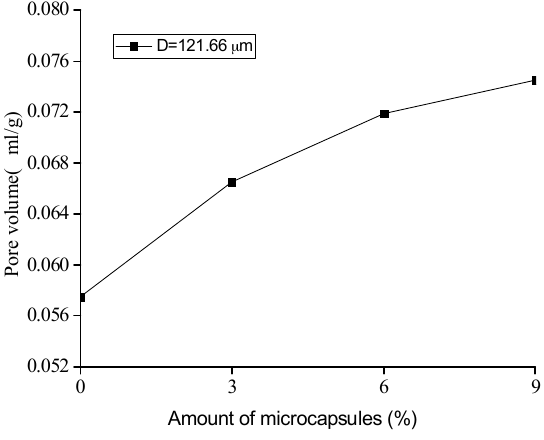
Figure 10. Variation in the porosity with amount of microcapsules.